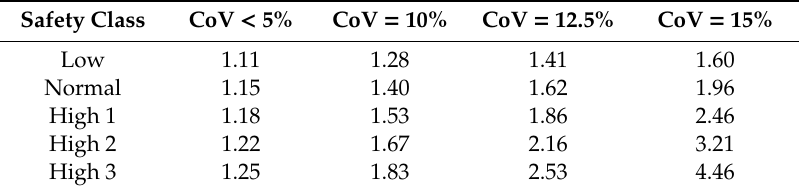
Table 8. Values of CS for brittle fracture, depending on the safety class and CoV of the material of the spheres, adapted from [44].